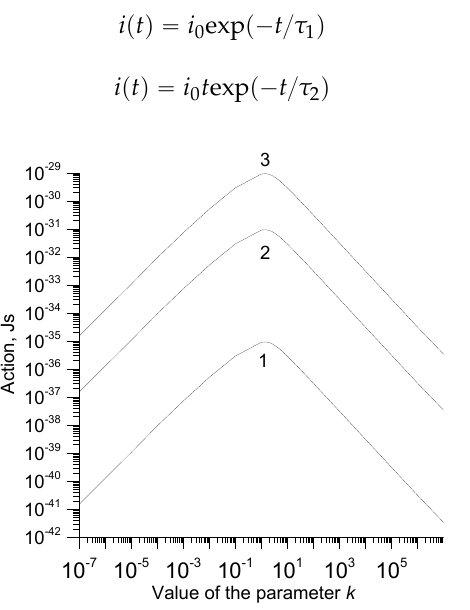
Figure 7. Energy dissipated by current pulses having a half sine wave shape carrying different charges as a function of the parameter k . (1) q = 1e ; (2) q = 100e ; (3) q = 1000e . Here e is the electronic charge. The action, as a function of k , for different values of charges is shown in Figure 8. Observe that the action has a maximum value close to the value k = 1. Recall that at k = 1, the duration of the current pulse matches the time of travel along the path. The value of this maximum decreases with decreasing charge and the lowest value corresponds to the lowest possible charge in the current waveform, namely, the electronic charge. The question is whether the presence of this maximum is unique to the particular current waveform used in the calculation or whether it is a general result. In order to check this point, the calculation is repeated with several other shapes for the current waveform and the results were observed to hold irrespective of the shape of the current waveform. The results obtained for the following two current waveshapes are presented as an example here.